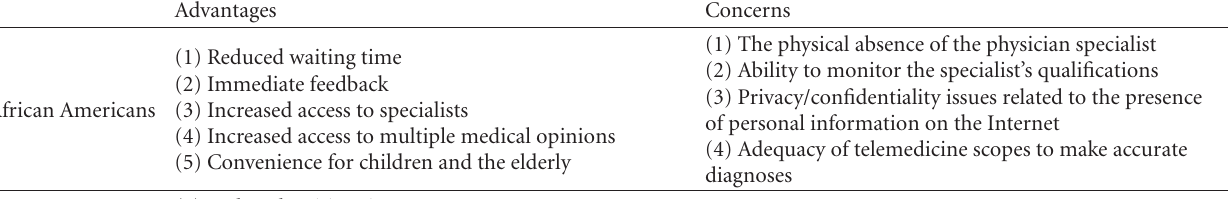
Table 3: Advantages and concerns about telemedicine for African American and Latino participants.